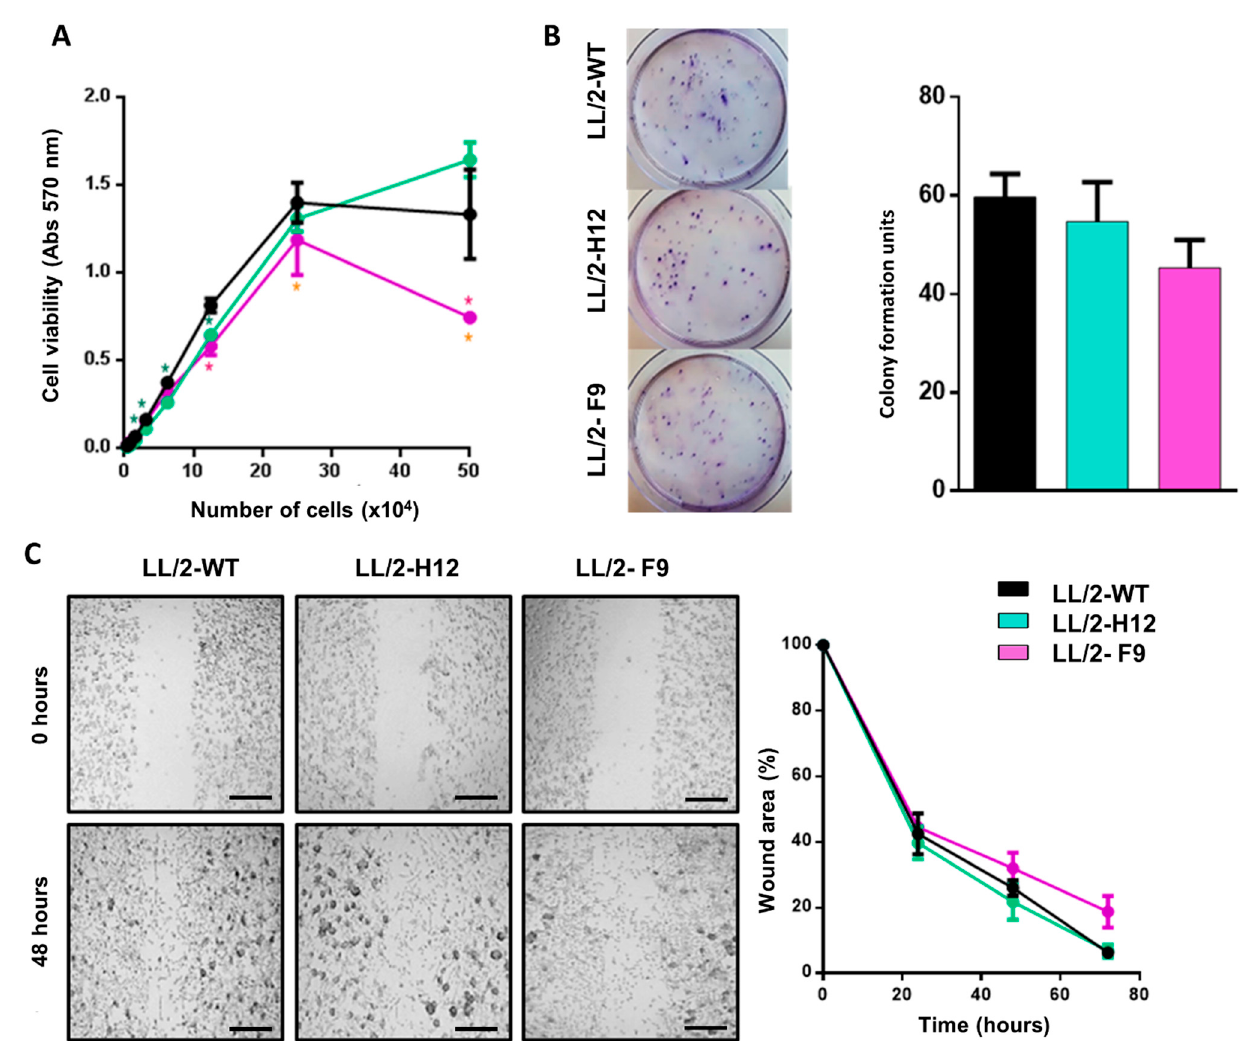
Figure 2. Tn + LL/2 cell variants present similar proliferation and migration properties to parental cell line. ( A ) Cell growth evaluated by viability with MTT. ( B ) Clonogenic ability of cells measured by colony forming assay. Number of colony formation units was counted manually per plate. ( C ) Cell migration by wound healing assay. Measures were taken at 0, 24, 48, and 72 h, and the area was determined using ImageJ. Wound area is represented as percentage or area relative to time point 0. was calculated. The images represent at time 0 and time 48 h. The black bar represents 100 µm Asterisks represent significant differences ( p < 0.05).